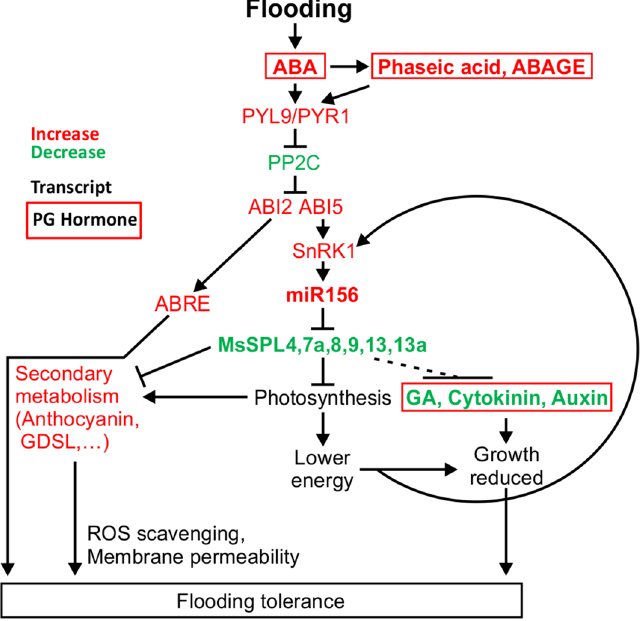
Figure 7. Proposed model for flooding tolerance in alfalfa. In flooding-tolerant cultivars, ABA is induced upon FS triggering PYL/PYR9 signaling molecules. This signaling pathway induces ABI2 and ABI5 while reducing the phosphorylated PP2C for increased expression of ABA-responsive elements, ABRE . ABA also induces a REM protein kinase SnRK1 along with its α and β subunits ( KIN10 and KIN11 ) through ABI5. The increased expression of SnRK1 may trigger miR156 and channels resources towards the phenylpropanoid pathway. Induced miR156 expression silences SPL13, to mediate anthocyanin biosynthesis by its interaction with DFR 24 , and other SPLs (SPL4, 7a, 8, 9 and 13a). The increased abundance of ABA metabolites antagonistically affects gibberellic acid, cytokinin and auxin hormones. To exploit the newly identified SPLs (1, 1a, 2a, 7, 7a, 8, 13a, 14 and 16) in alfalfa breeding, it will be necessary to investigate their functional roles individually and in combination in response to FS and other physiological